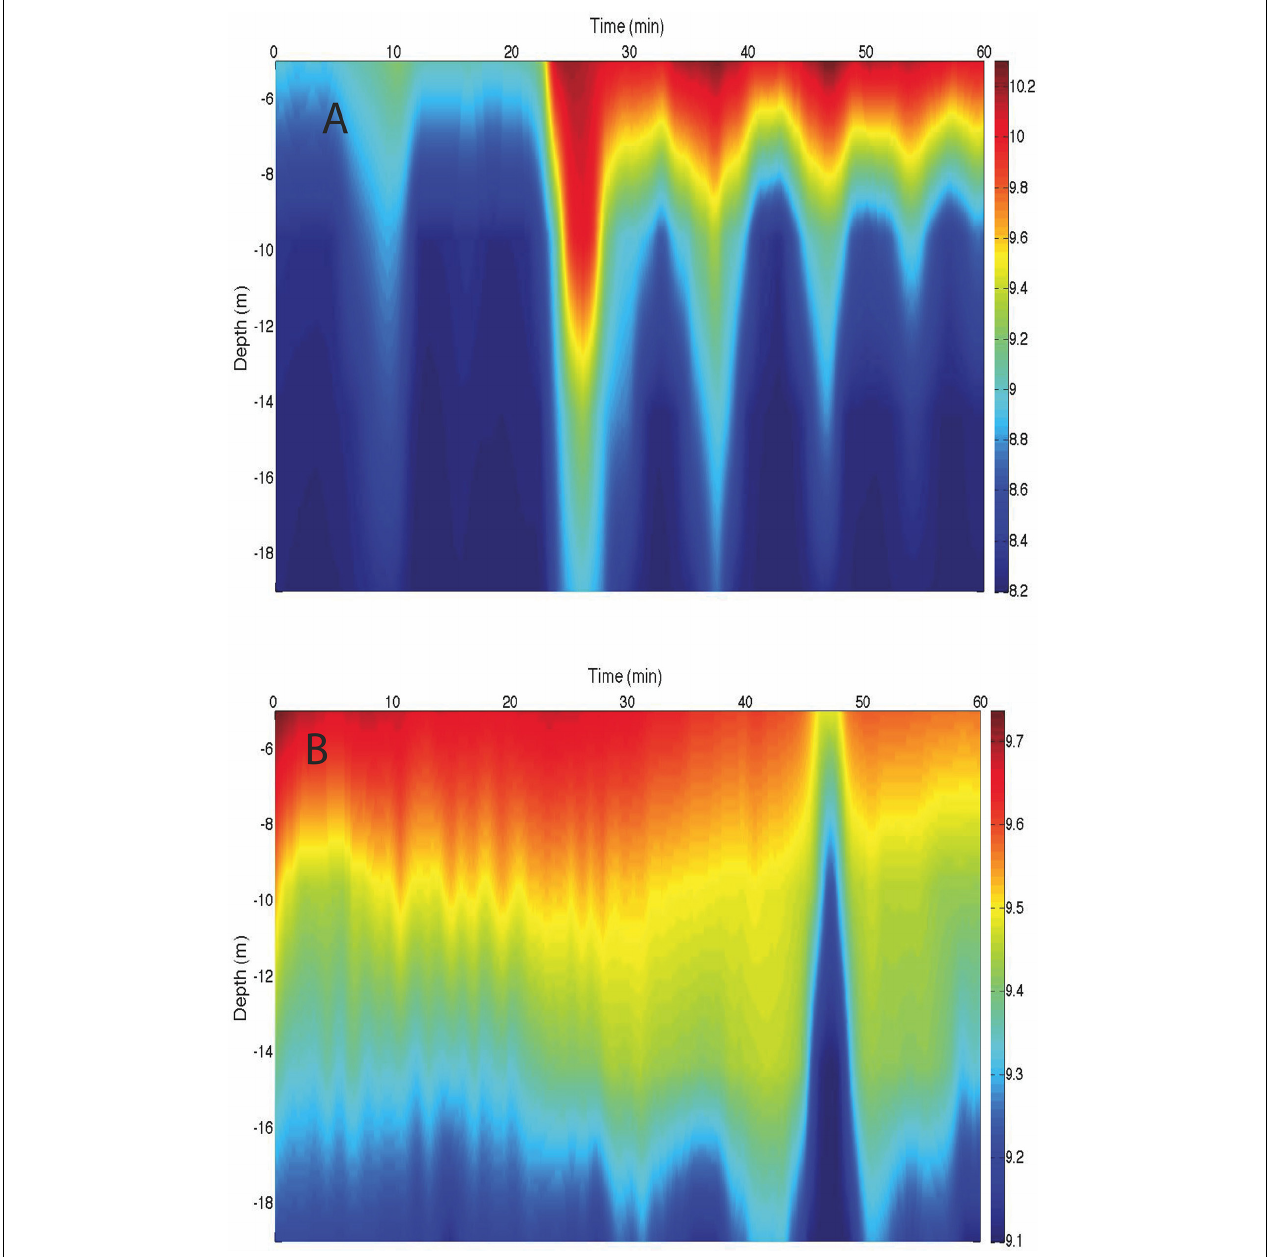
FIGURE 2 | (A) Internal waves of depression. (B) An internal wave of elevation is present at about 48 min. To the right of each figure the scale bars are temperature in ◦ C. Depth is in meters. The data were collected with a chain of thermistors on a mooring placed off Coos Bay, Oregon (43.36 N, 124.37 W). Images are from L. Rasmuson (personnel